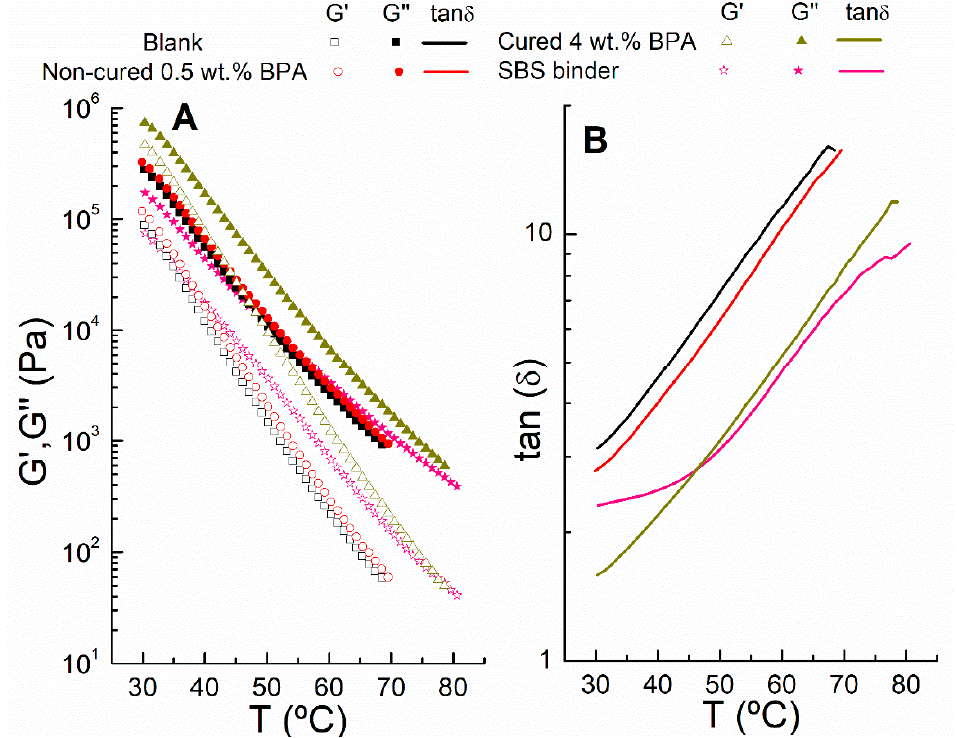
Figure 5. Dependence on temperature for selected binders of: ( A ) elastic (G’) and viscous (G”) moduli; and ( B ) loss tangent (tan δ = G”/G’).